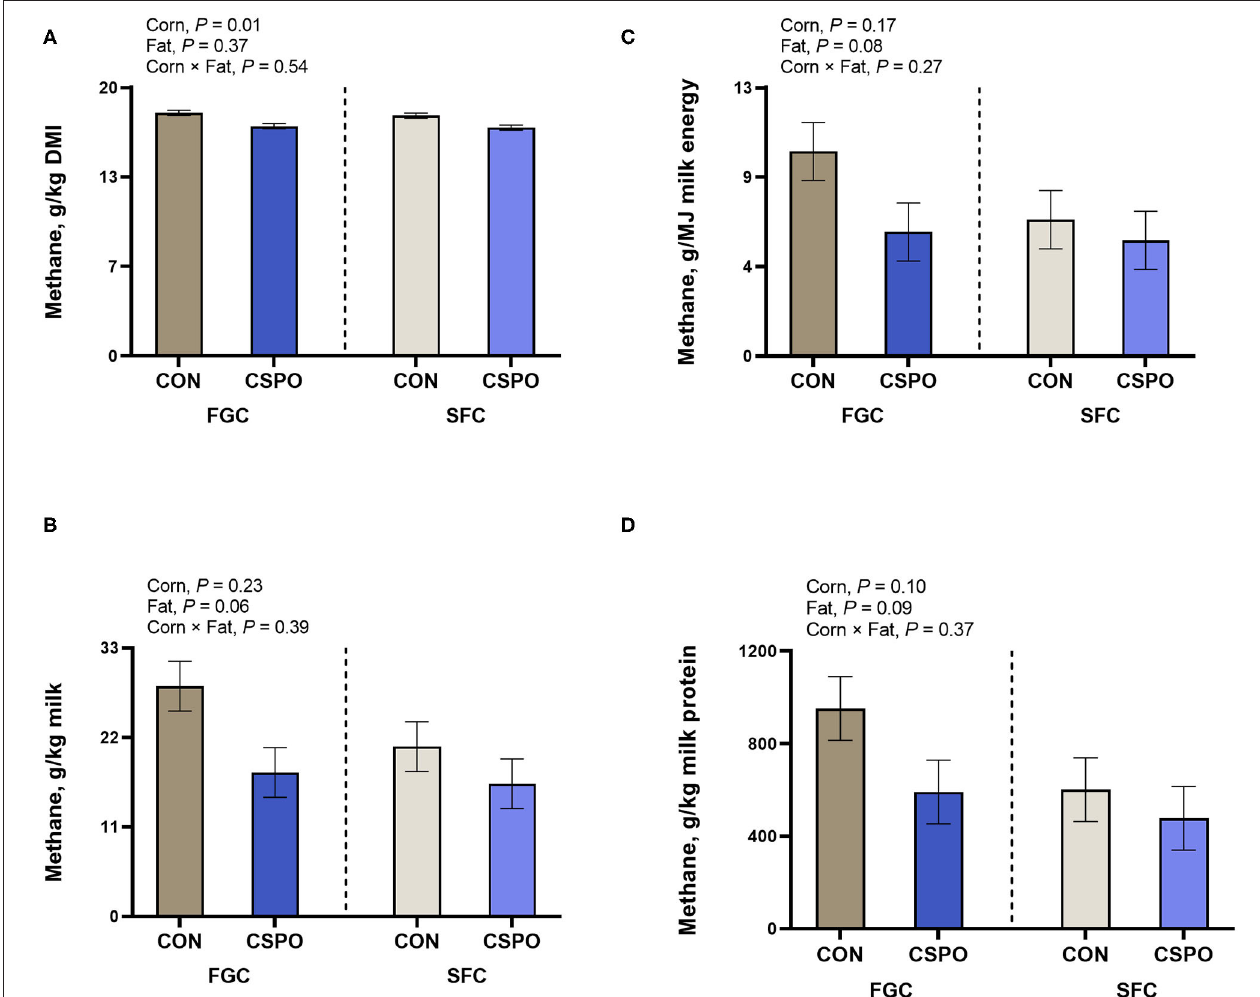
FIGURE 4 | Estimated methane output (A–D) in cows that grazed elephant grass and received treatments as a concentrate supplement. The concentrate contained either fine ground corn (FGC) or steam-flaked (SFC) corn associated or not with supply of Ca salts of palm fatty acids (not supplemented – CON or supplemented –